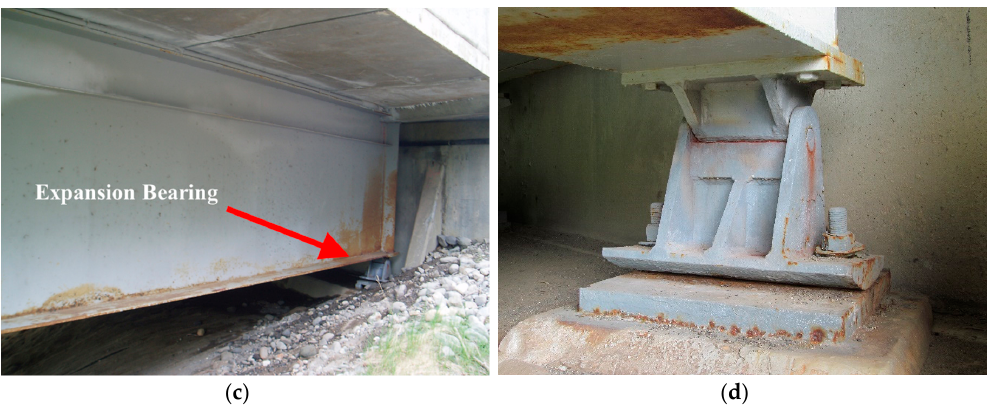
Figure 1. Photographs: ( a ) Chulitna River Bridge; ( b ) Bridge bottom view; ( c ) Expansion bearing at the bridge end; ( d ) Expansion bearing.